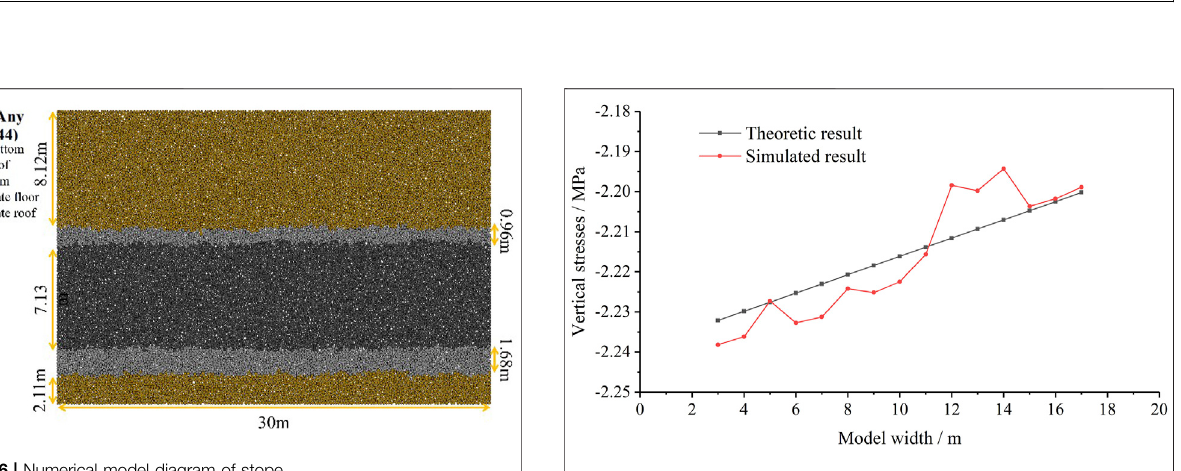
FIGURE 5 | Experimental results of various strata simulation. (A) Model compressive strength curve. (B) Model tensile strength curve.